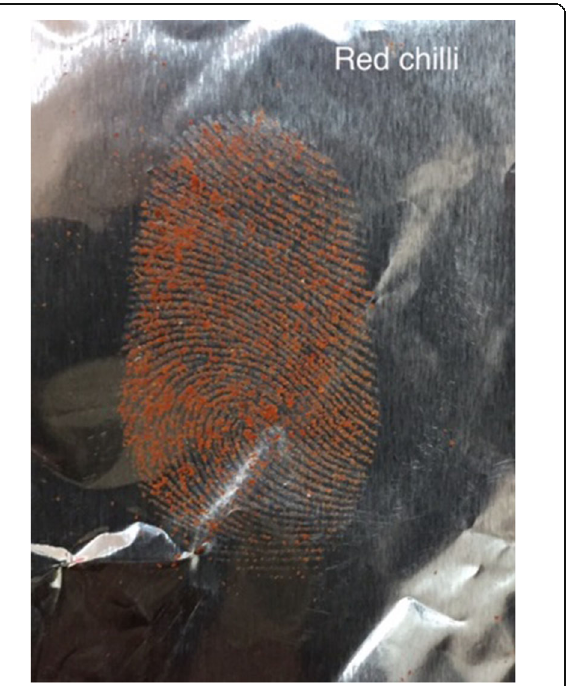
Fig. 11 Development of Latent fingerprint by Turmeric powder on Aluminum Foil